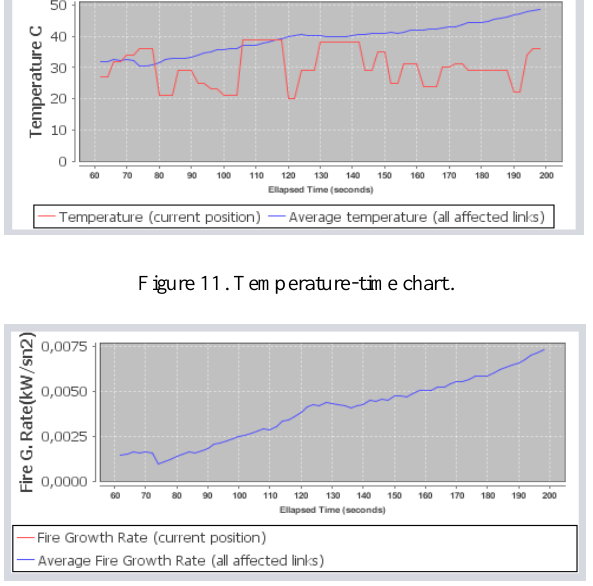
Figure 12. Fire growth rate-time chart.